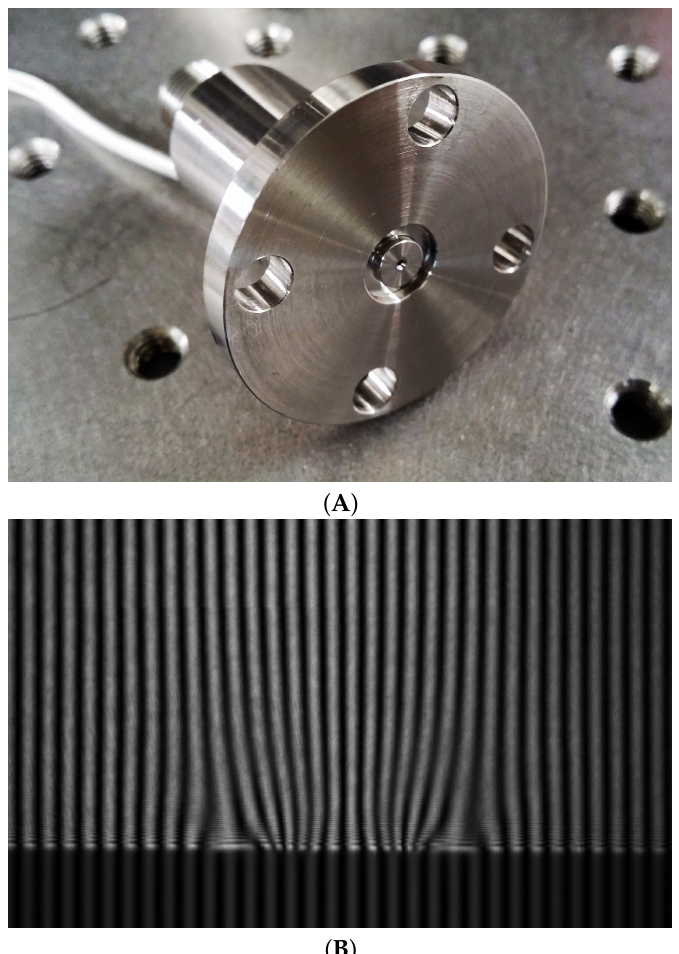
Figure 6. Parker solenoid valve and interference fringes. ( A ) Miniature high speed high vacuum dispensing valve with a conical outlet (Parker 009-0442-900 ); ( B ) typical interference fringes of the Parker solenoid valve at 35 bar backing pressure with argon. Here, the gas flow is directed upwards. The two non-straight areas correspond to positive and negative phase differences ∆ φ (see Equation